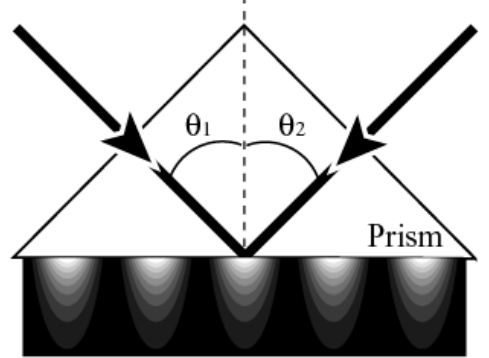
Figure 6. Optical arrangement for evanescent interference